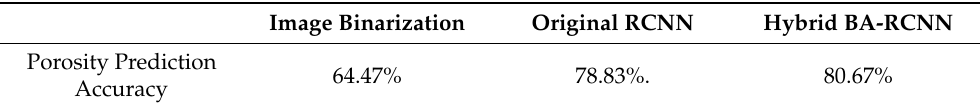
Table 8. Porosity prediction accuracy (first version).